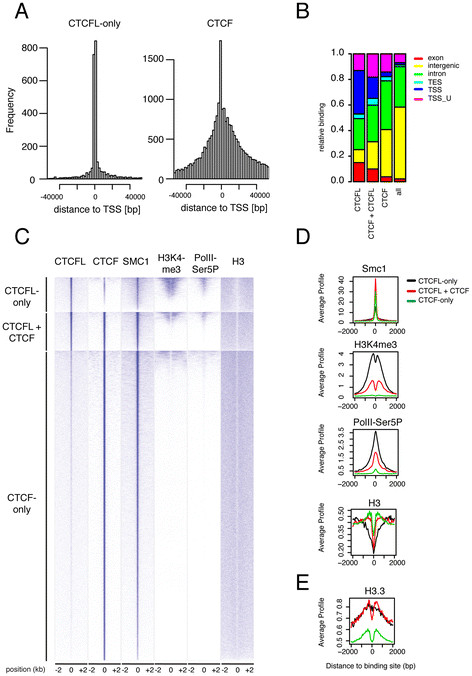
Characterization of CTCFL and CTCF binding. A A large fraction of CTCFL-binding sites is located close to promoters. We determined for each CTCFL-only-binding site the distance to the nearest transcriptional start site (TSS) and plotted the frequencies of binding sites in the depicted window from −40 kb to +40 kb around the center of CTCFL-binding sites. CTCF is plotted as comparison. B Comparison of the genomic distribution of CTCF- and CTCFL-binding sites. Sites are separated into CTCF-only, CTCFL-only and (CTCF + CTCF). The entire genome is also plotted (all). The binding location is separated into exon, intron, intergenic, transcription start site (TSS) and transcriptional end sites (TES), and plotted as frequencies of total (Y ax). C Clustered heatmap representation of the three different classes of CTCF/CTCFL-binding sites with respect to chromatin context. We compared CTCF and CTCFL binding to published ChIP-sequencing data sets for the cohesin complex subunit Smc1, H3K4me3, a phosphorylated form (serine 5) of RNA PolII, (PolIISer5P) and histone H3 [8,42,43]. D Cumulative profiles across the three different classes of CTCF/CTCFL-binding sites with respect to chromatin context. The average ChIP-sequencing profiles are shown for the same data sets as in (C). E Cumulative profiles across the three different classes of CTCF/CTCFL-binding sites with respect to H3.3.